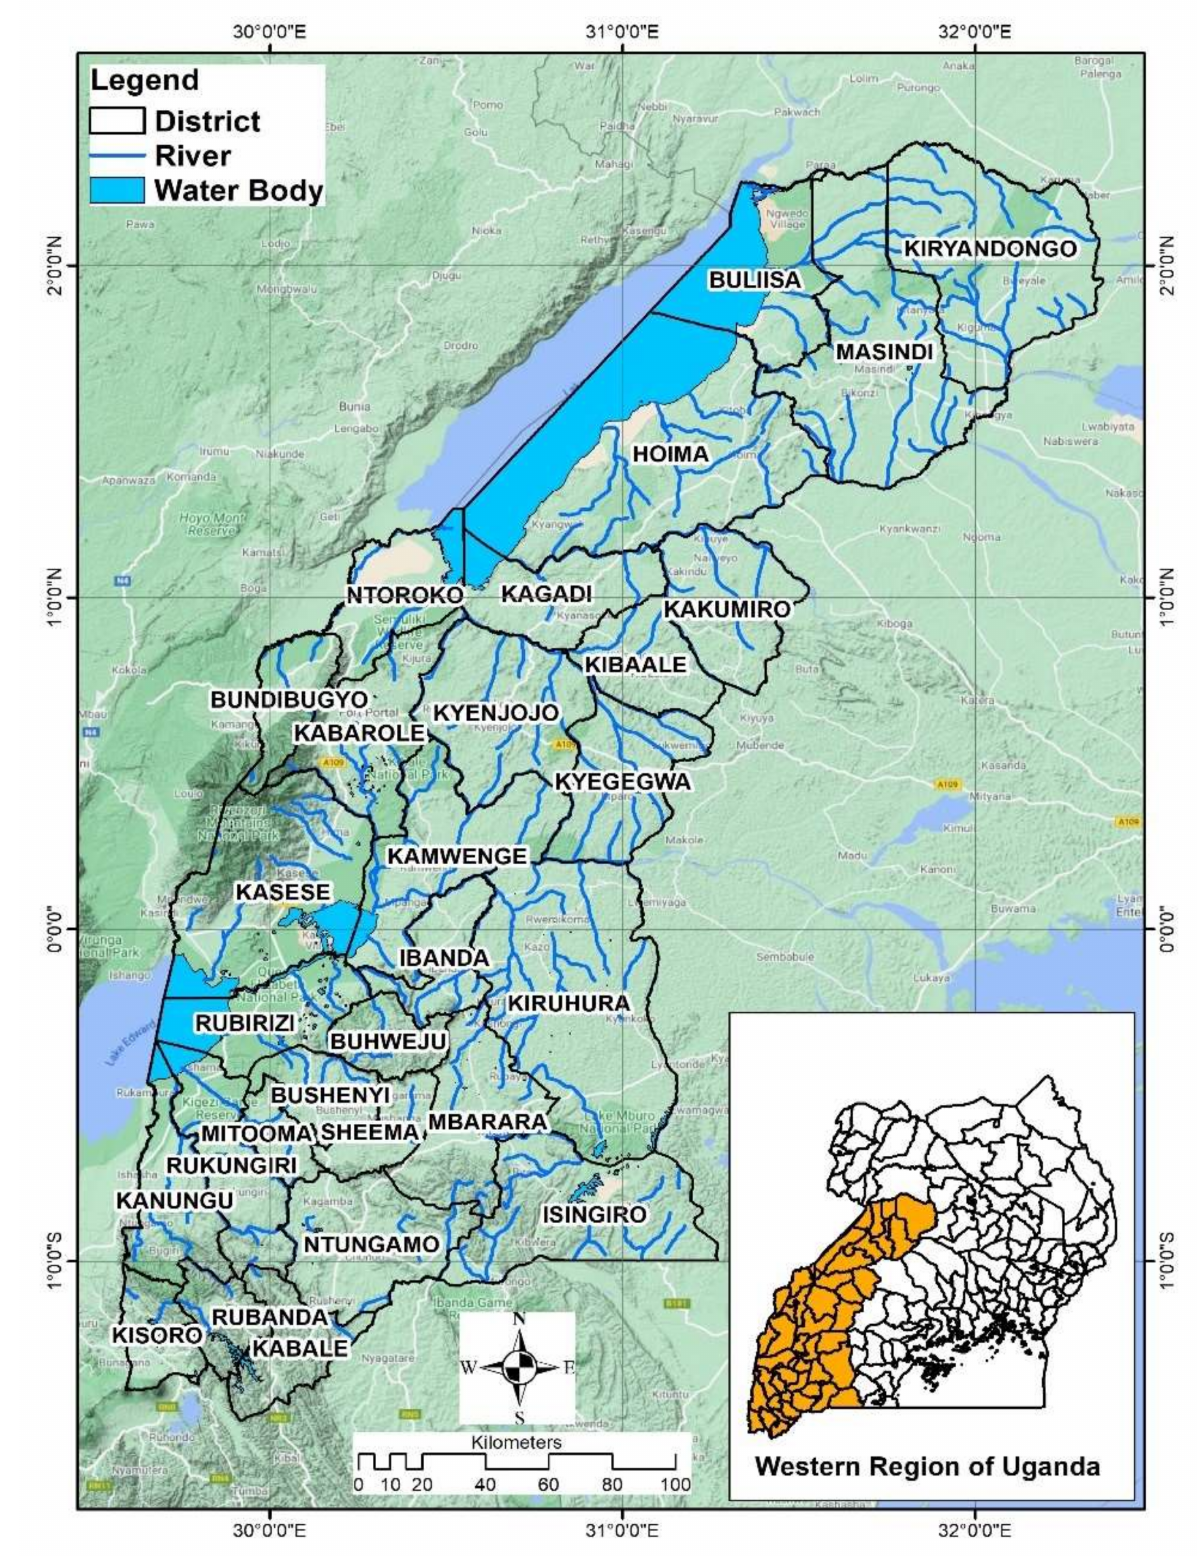
Figure 7. Map of waterbodies in the study